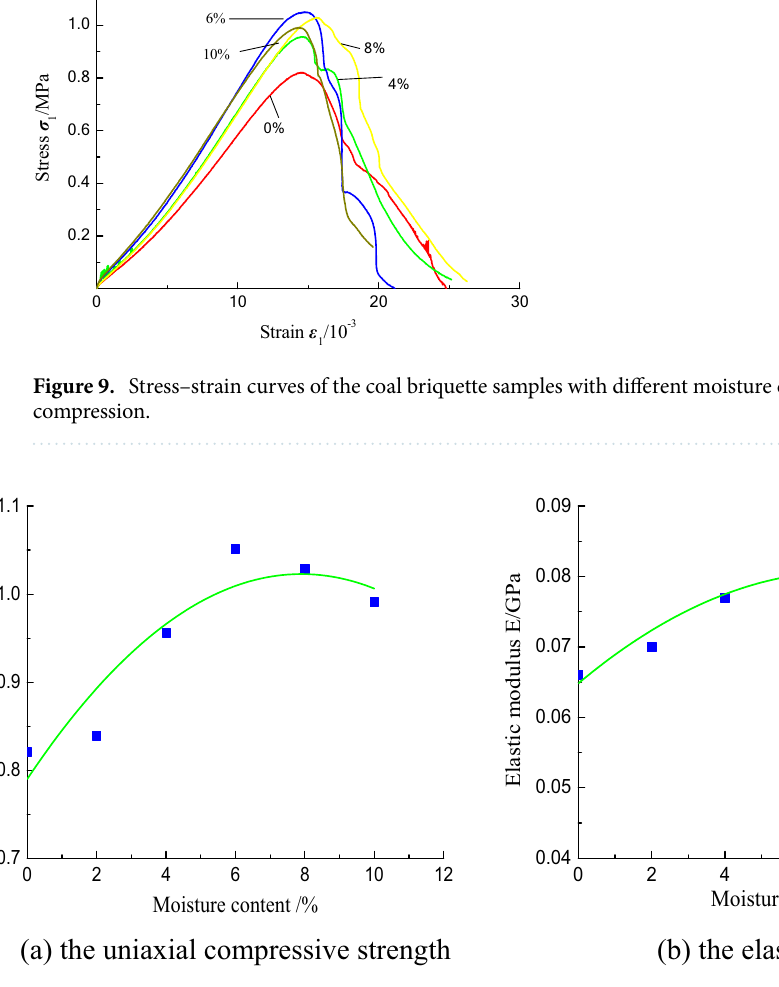
Figure 10. The fitting curves of the moisture content versus ( a ) the uniaxial compressive strength and ( b ) the elastic